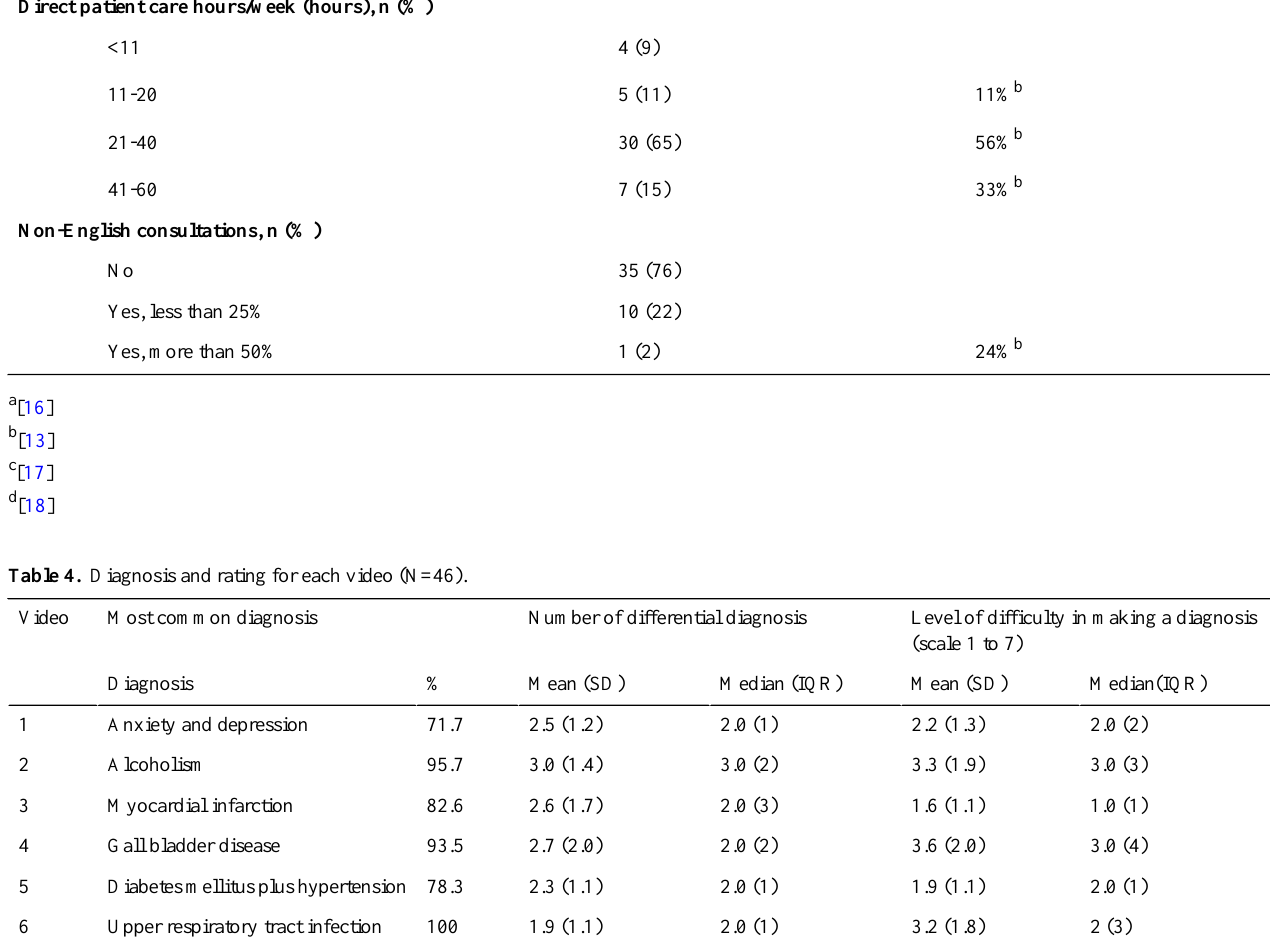
Table 5. Comments made by GPs regarding intention of continuing with each video consultation (N=46).